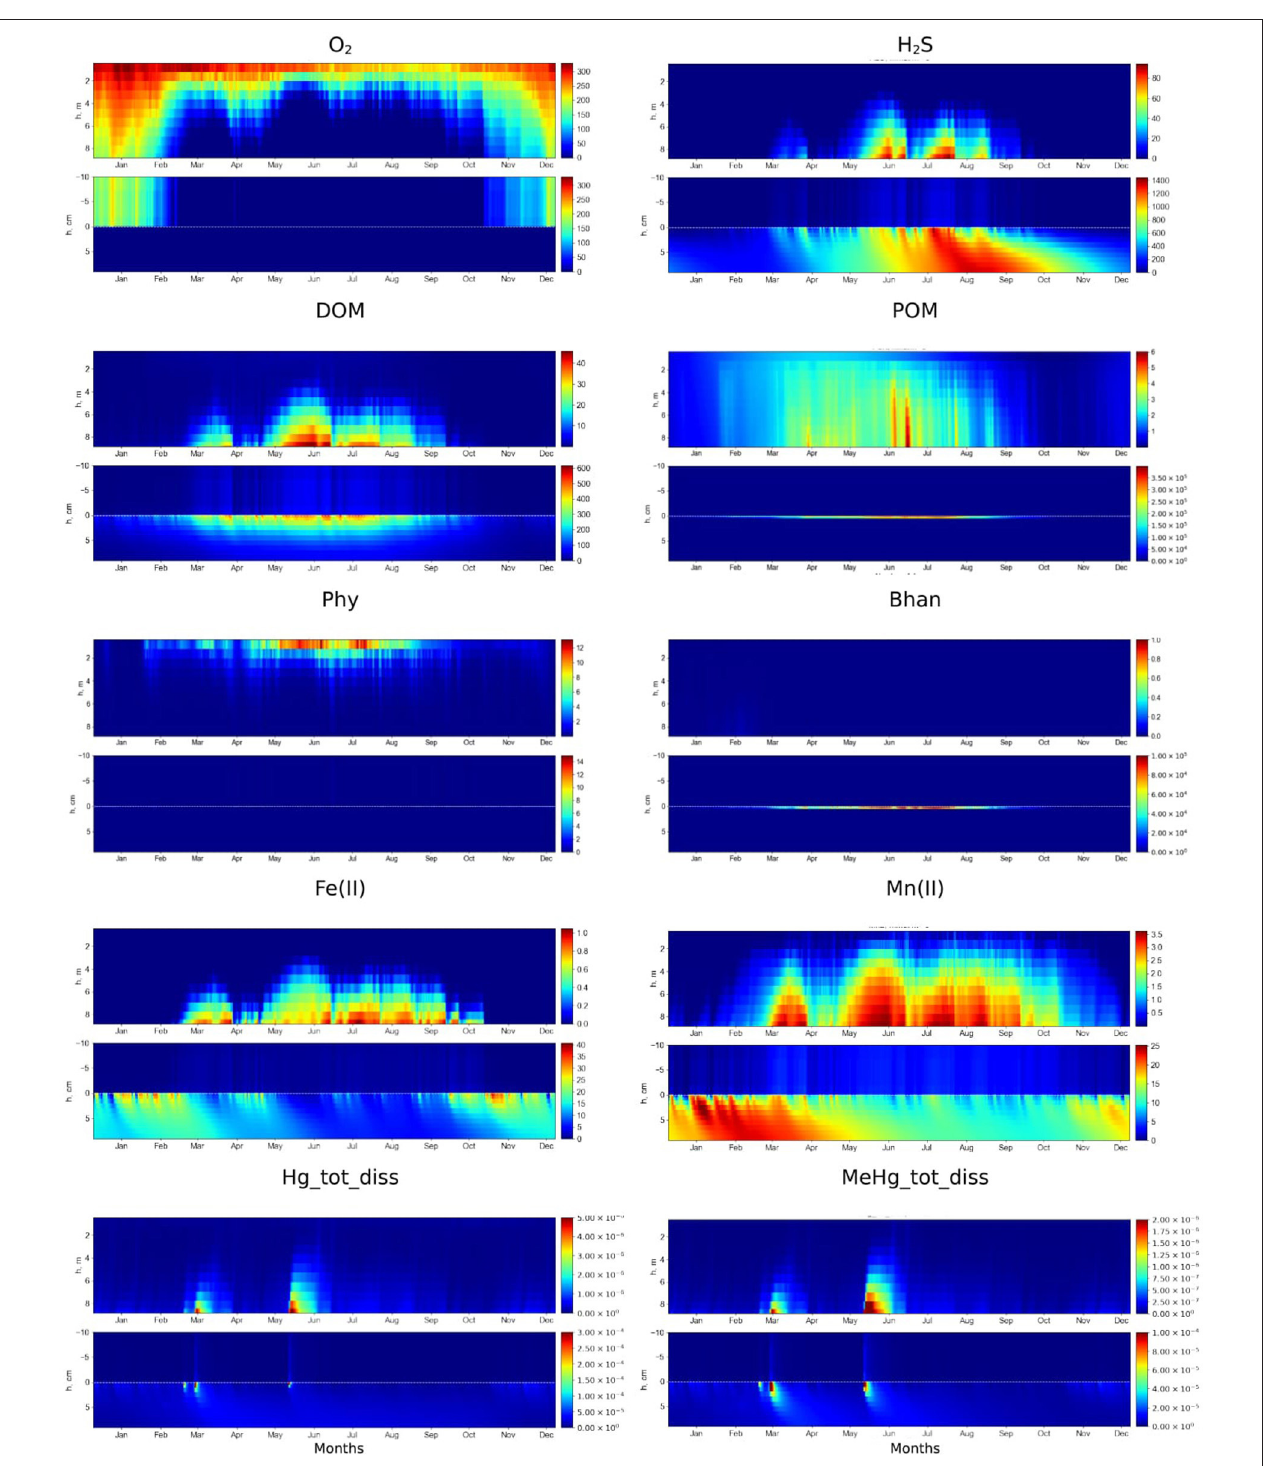
FIGURE 3 | Simulated seasonal dynamics of dissolved oxygen, hydrogen sulfide, DOM, POM, phytoplankton (Phy), anaerobic heterotrophic bacteria (Bhan), dissolved Fe(II), Mn(II), total dissolved Hg and MeHg ( µ M) in the water column and at the sediment-water interface ( ± 10cm) in the Berre lagoon according to scenario S1.